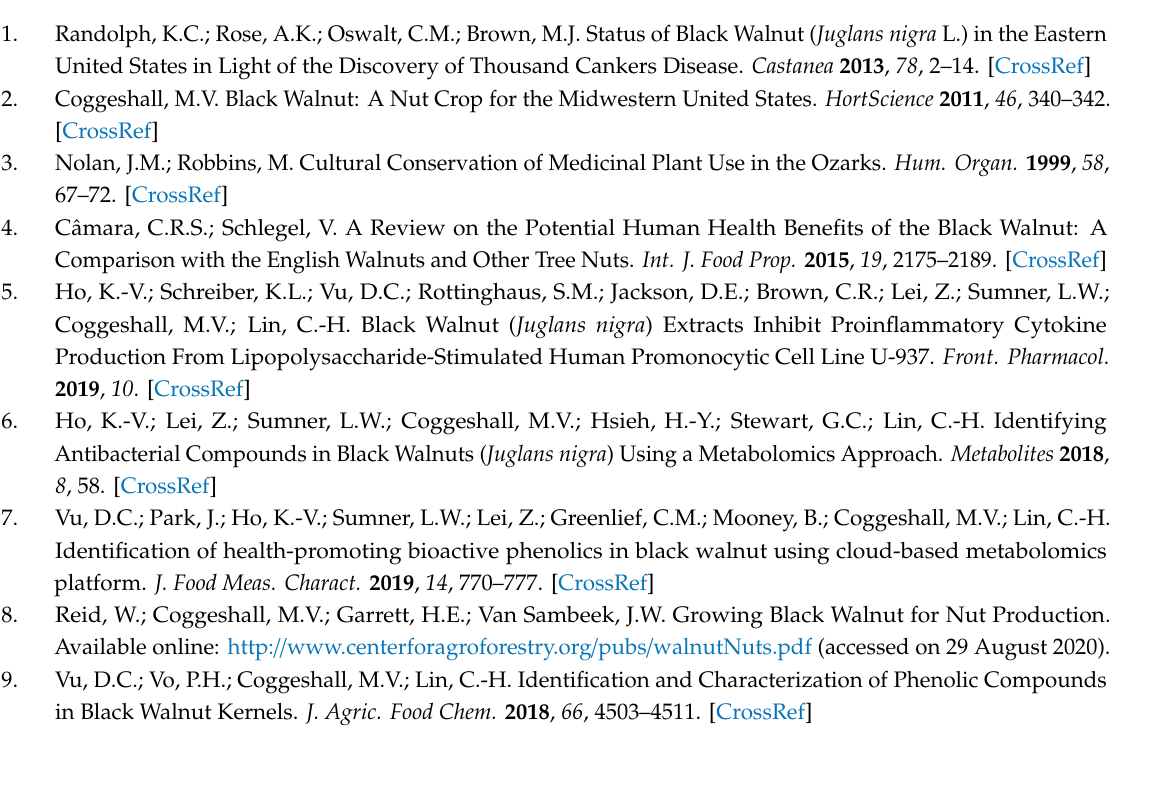
Supplementary Materials: The following are available online. Figure S1: Data distribution of controls (Trolox, DL-sulforaphane, tert- butylhydroquinone) in total antioxidant capacity and antioxidant response element (ARE) activation assays. Figure S2: Data distribution of controls (Trolox, DL-sulforaphane) in cytotoxicity